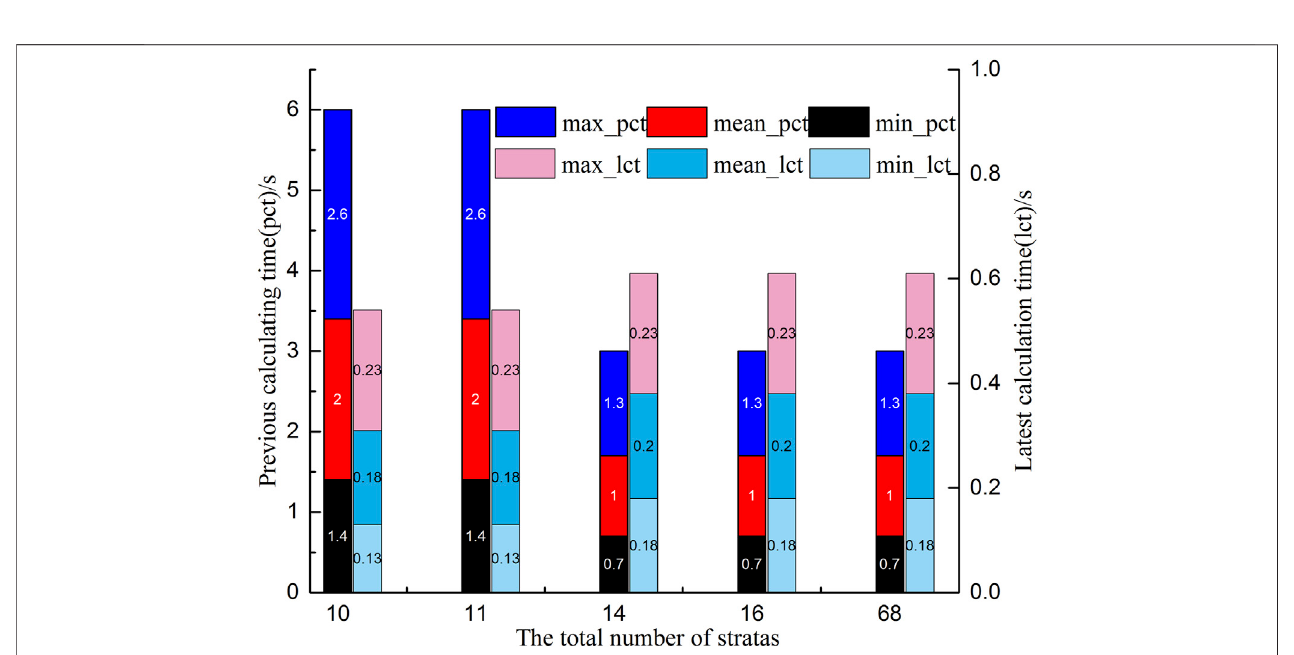
FIGURE 12 | Comparison of the calculate